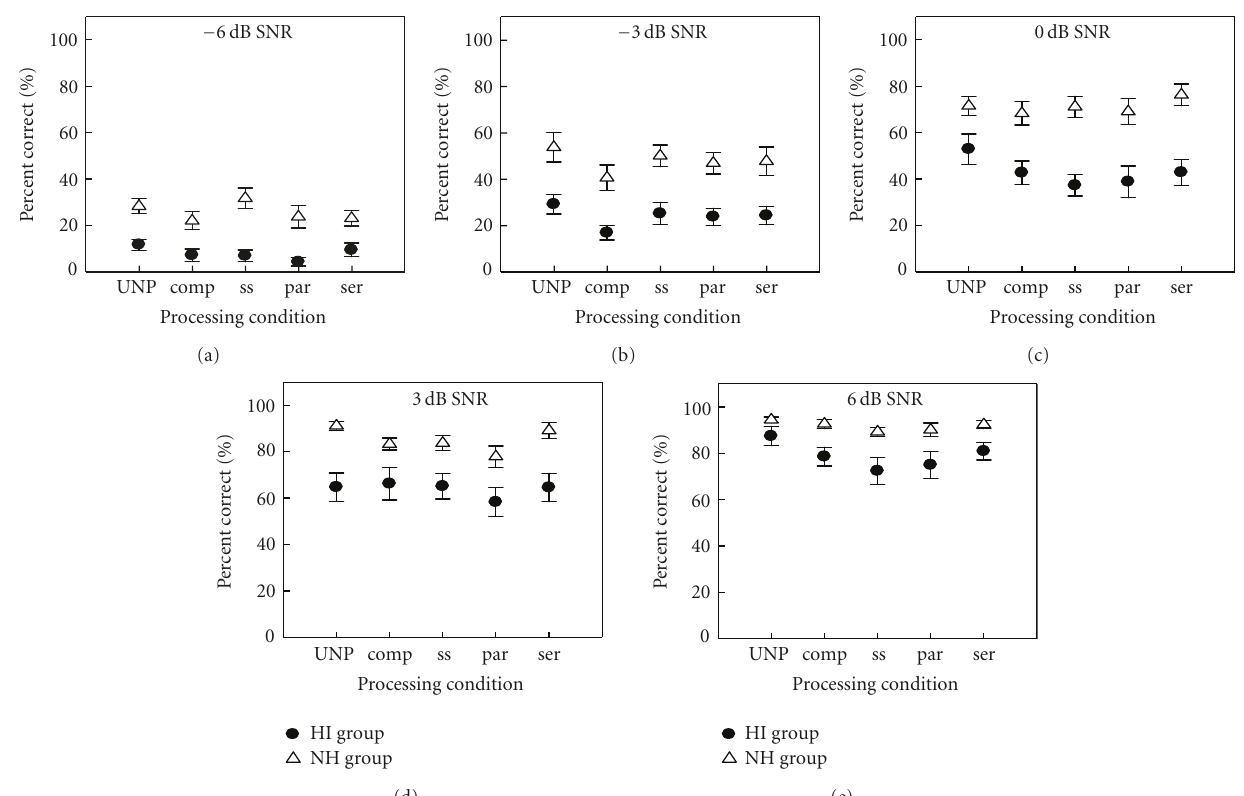
Figure 7: Intelligibility scores (in percent correct) for listeners with normal hearing (open triangles) and listeners with hearing loss (closed circles) grouped by SNR. Error bars represent standard error. Conditions are UNP: unprocessed, comp: dynamic range compression, ss: spectral subtraction, par: parallel, and ser: